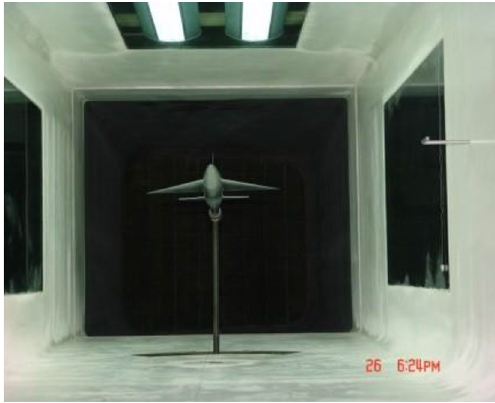
Figure 8. Diagram of ice shape regulation test.